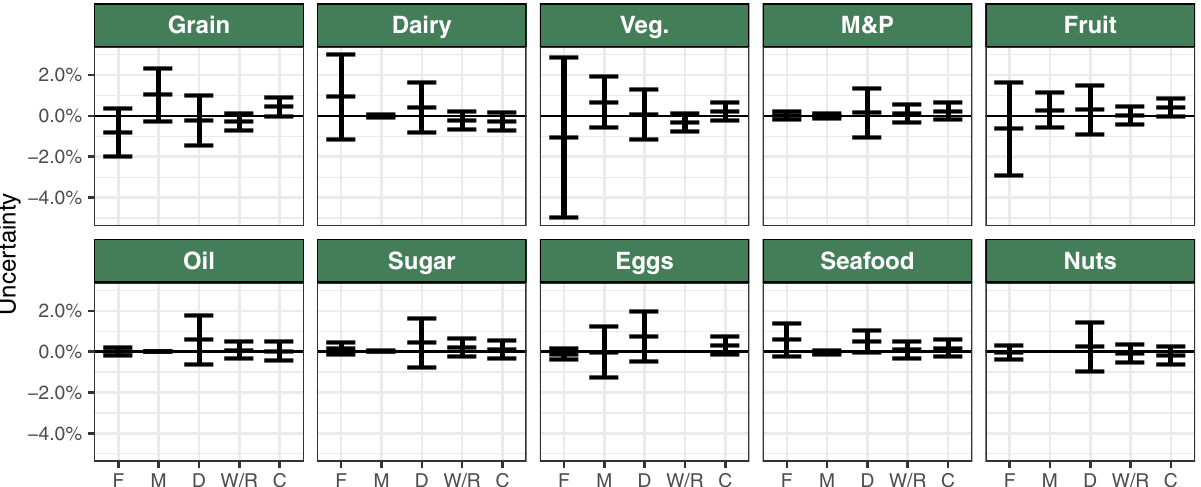
Fig. 7 Comparison between estimated FLW and the distribution of simulated amounts. The estimated result and lower bound, upper bound, and the mean value of the 95% con fi dence intervals for the different stages. The 10 commodities are represented with their own labeled panel (M&P represents meat and poultry) and each stage is a different set of error bars (on-farm production [F], food manufacturing [M], distribution [D], wholesale & retail [W&R], and consumption